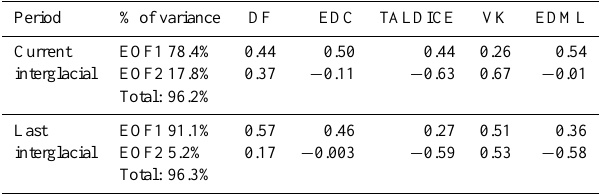
Table 3. Principal component analysis of the five smoothed δ 18 O records for the present and last interglacial periods: percentage of variance explained by the first and second EOF and their sum, and linear coefficients applied to each record. The third EOF accounts for ∼ 2.5% of variance and is not displayed. TD is not included due to its low resolution and dating accuracy for the last